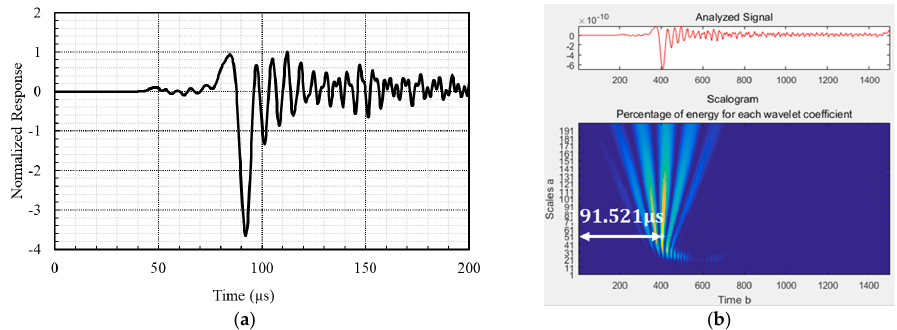
Figure 5. Measured time history of surface wave motion and the contour plot of the Morlet wavelet for the propagating waves. ( a ) Measured signal; ( b ) Travel time calculation with the Morlet wavelet.